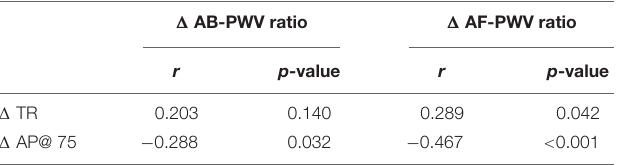
TABLE 3 | Correlations between changes in arterial stiffness gradient and changes in wave reflection